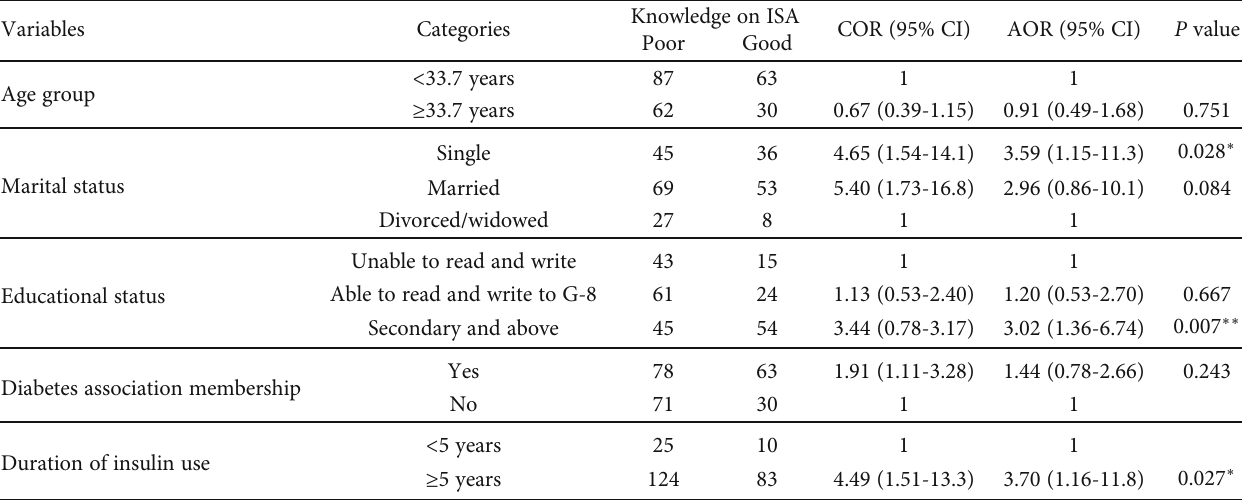
Table 4: Bivariate and multivariable logistic regression analyses of factors associated with good knowledge on ISA among type 1 diabetic patients at MKRH,